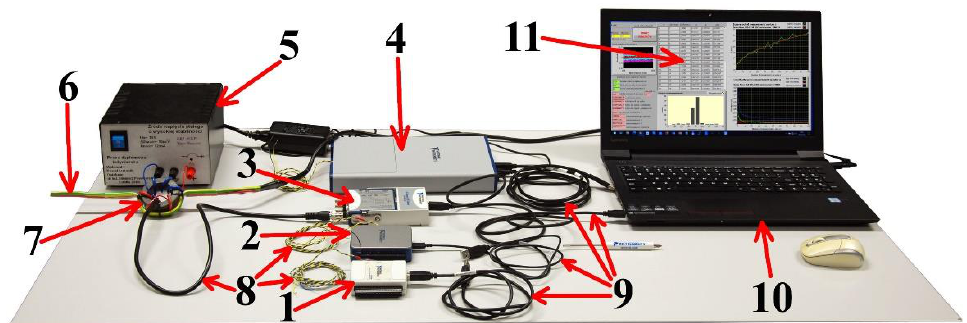
Figure 3. View of the measurement stand: 1—NI USB-6008 module; 2—NI USB-6001 module; 3—NI USB-9215 module; 4—NI-USB-6341 module; 5—REF102 reference voltage source; 6—power supply line 230 V; 7—ferromagnetic core FC; 8—signal wires; 9—USB cables; 10—computer controlling measurements; 11—application in LabVIEW